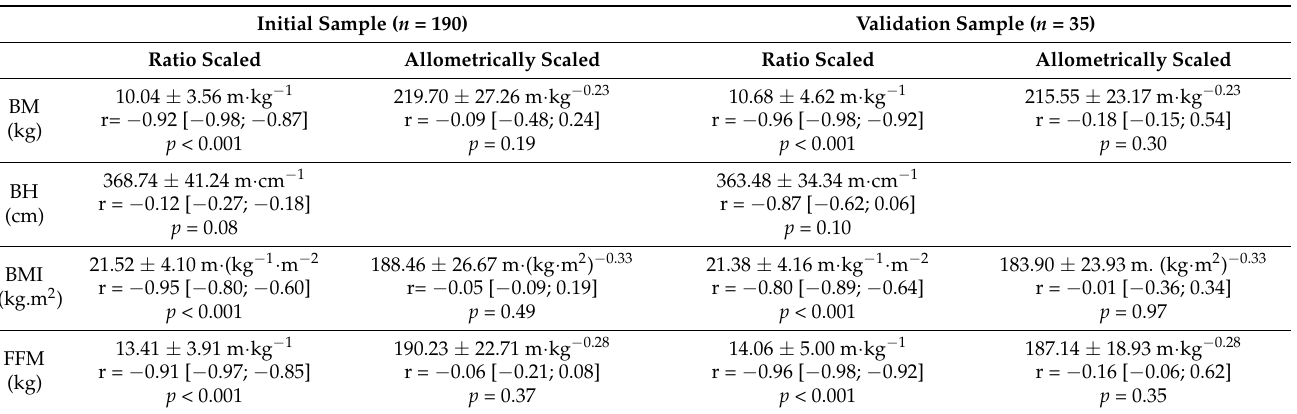
Table 3. Correlations [95% CI] between ratio scaled and allometrically scaled 6MWD with body size variables in initial sample and validation sample